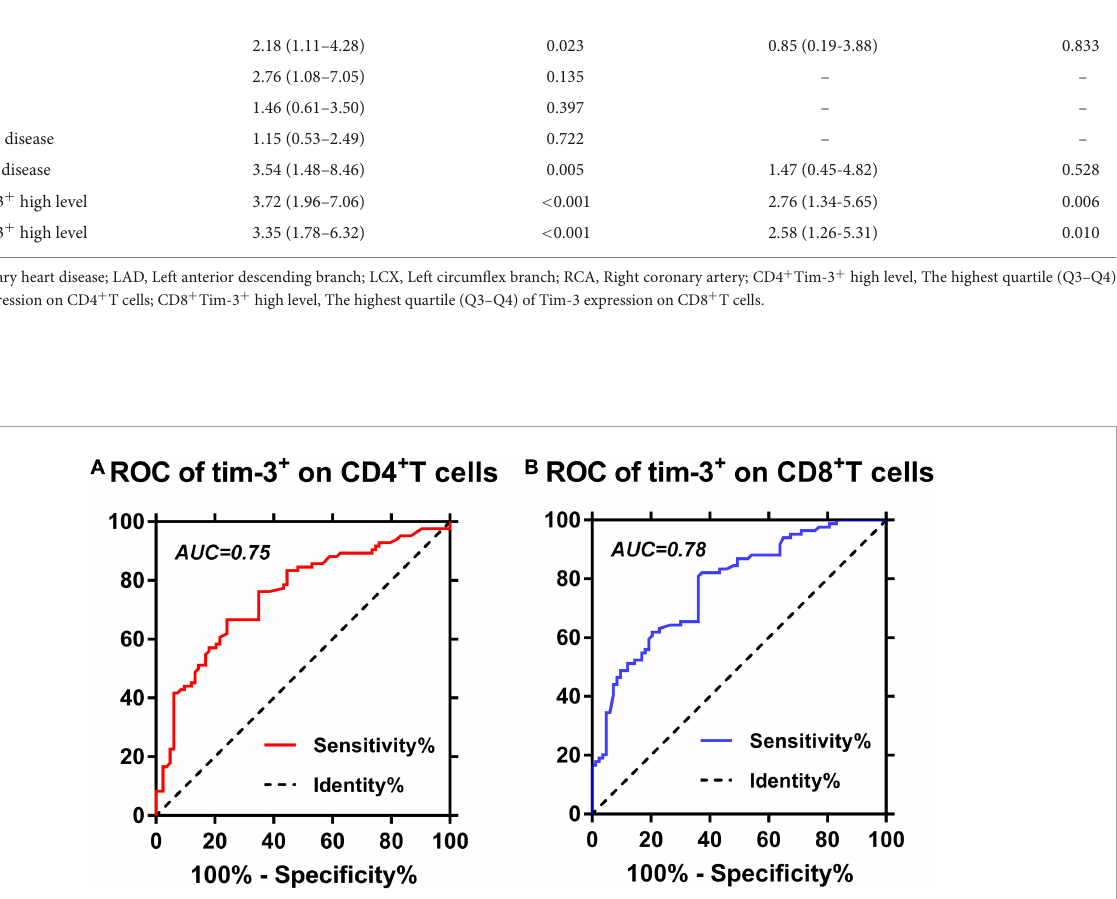
FIGURE3 Predictive performances of Tim-3 expression on CD4 + and CD8 + T cells. (A) ROC curves for Tim-3 expression on CD4 + T cells. (B) ROC curves for Tim-3 expression on CD8 + T cells.